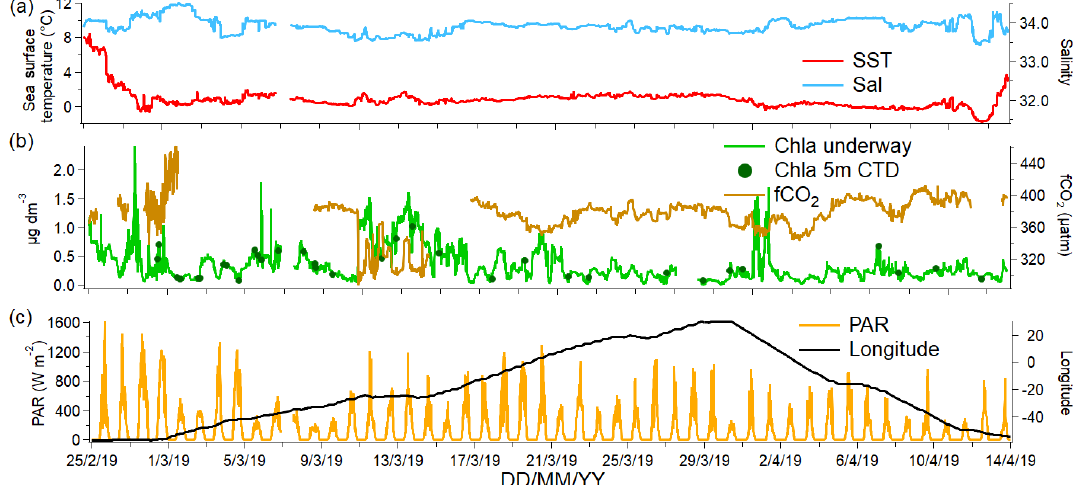
Figure 2. (a) Sea surface temperature and surface salinity, (b) chlorophyll a concentrations measured underway and from the sensor installed on the CTD sensor at 5m depth as well as underway f CO 2 , and (c) photosynthetic active radiation along with the longitude measured along the cruise